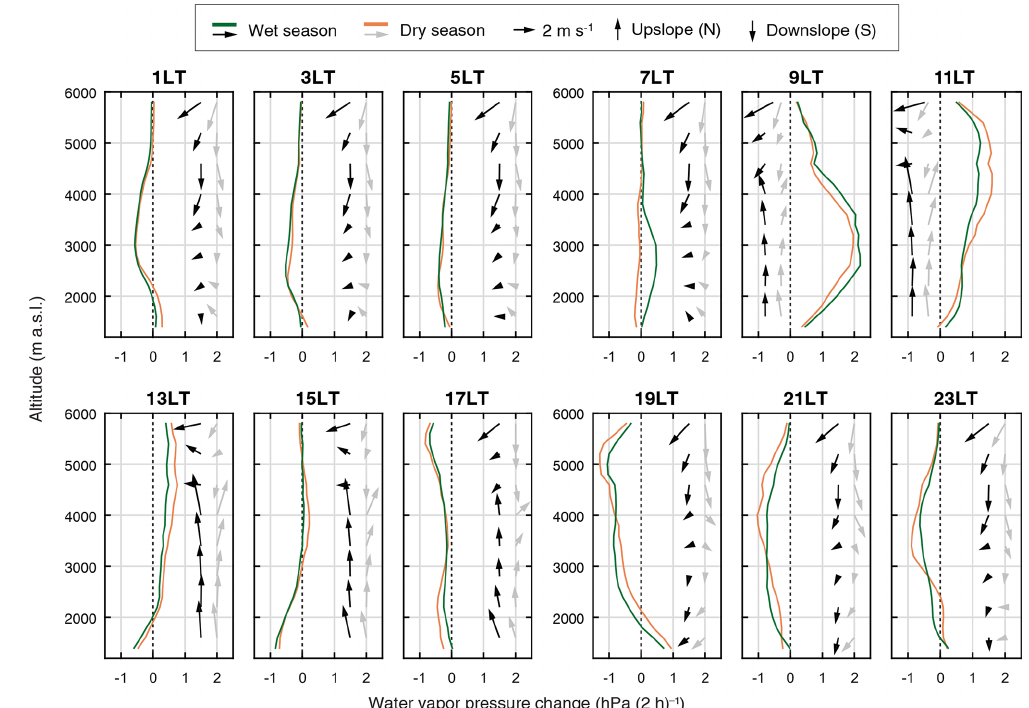
Figure 9. Mean diurnal cycle of the 2-hourly water vapor pressure change (until the indicated time) on Kibo’s southern slope at 2m height for the climatological dry (JF, JJAS) and wet (MAM, OND) seasons in brown and green, respectively, between 8 October 2009 and 30 September 2013. Area-averaged mean horizontal wind vectors at 10m height are drawn for 600 m bins from 1600 to 5800ma.s.l. (as on a map from north) at arbitrary x -axis locations, typically at x = 1 . 5 (wet season, black) and x = 2 (dry season, grey) except for 09:00 and 11:00LT to avoid overlap with the line plot. Note that the change analyses obfuscate the fact that the bulk of the water vapor (mean pressure > 10hPa continuously) is always found between the mountain base and